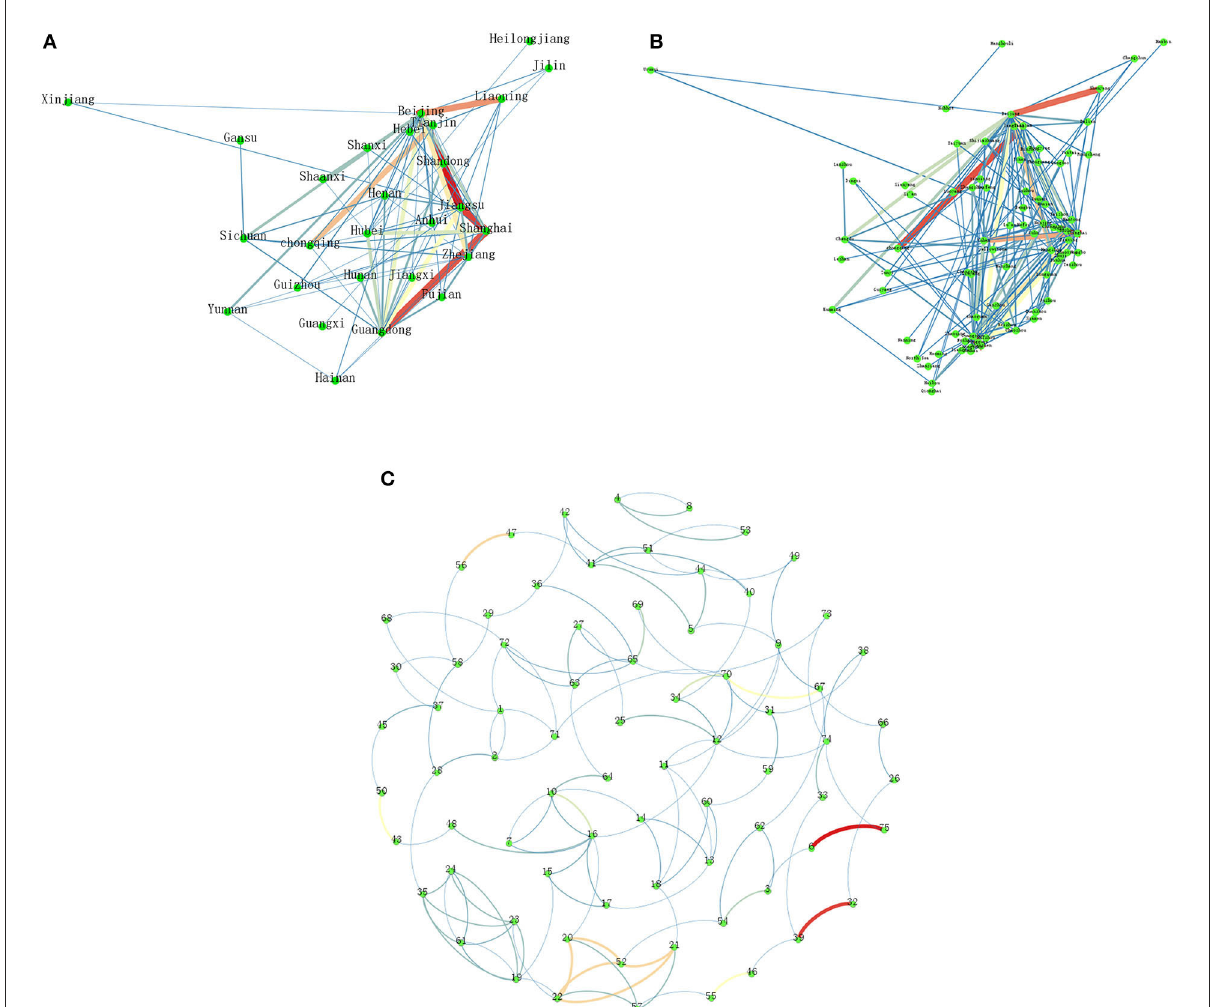
FIGURE1 COVID-19 patent cooperation networks. (A) Inter-provincial COVID-19 patent cooperation network. (B) Inter-city COVID-19 patent cooperation network. (C) Inter-applicant COVID-19 patent cooperation network. Line thickness and red–yellow–green colors represent